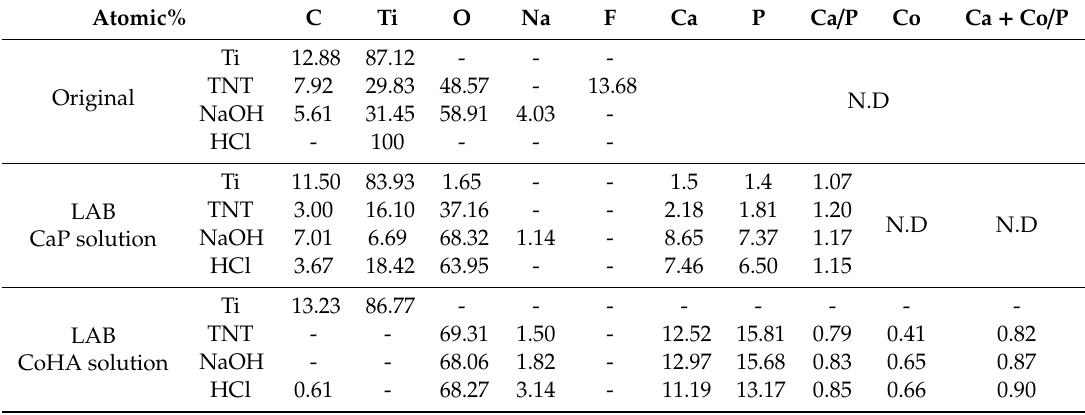
Table 2. Surface element analysis of the titanium sheet with di ff erent surface treatments and samples after LAB treatments by